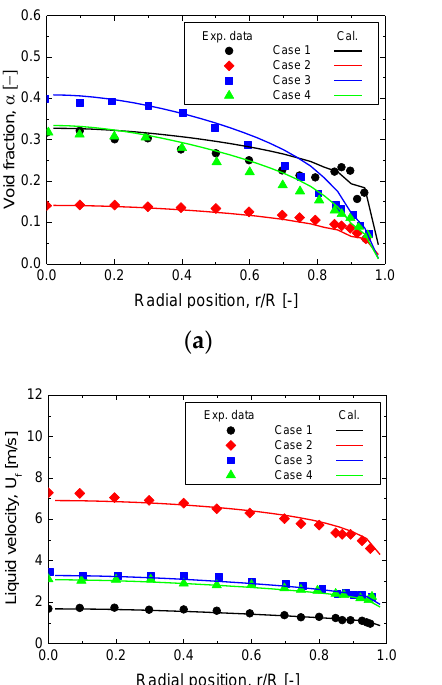
Figure 5. Comparison of the predicted two-phase parameters with the DEDALE experiment: ( a ) void fraction, ( b ) bubble diameter, ( c ) liquid velocity, and ( d ) gas velocity.